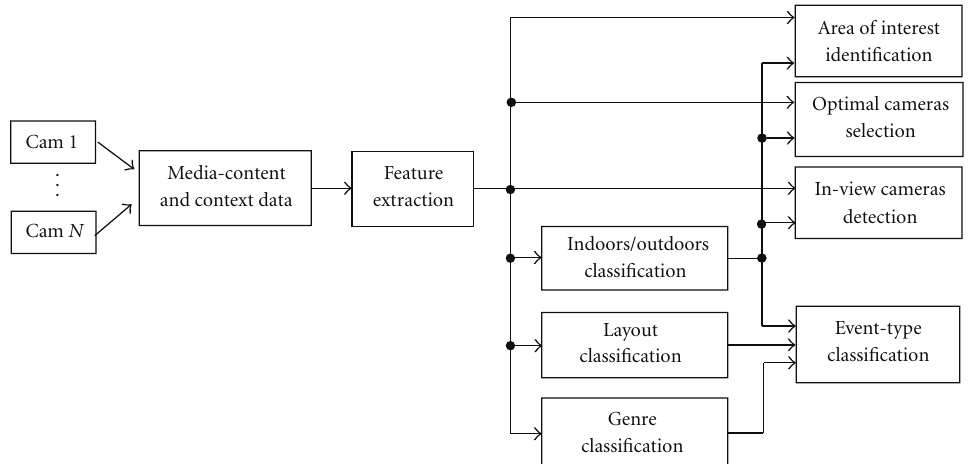
Figure 2: Processing steps for extracting semantics from content data and context data (i.e., auxiliary sensor data captured by the electronic compass, the accelerometer, and the GPS receiver) captured by multiple cameras (denoted in the figure as “Cam”) in a public